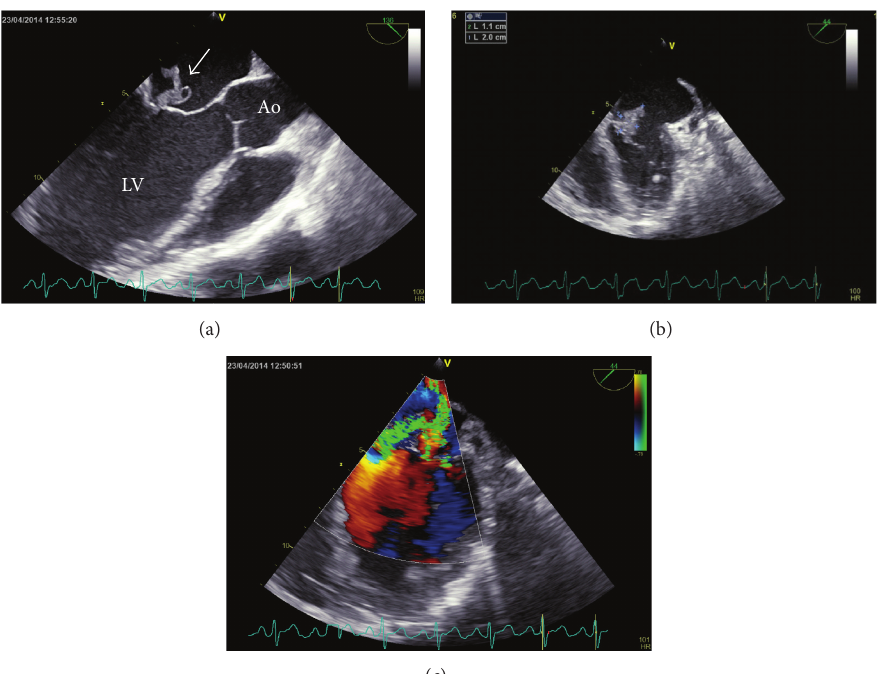
Figure 2: Transesophageal echocardiography (TEE): (a) 3-chamber view of the heart: floating vegetation (white arrow) on the anterior mitral leaflet; Ao = aorta; LV = left ventricle. (b) Another projection of the floating vegetation (11mm × 20 mm) and the destroyed mitral valve. (c) Color Doppler sonography shows severe mitral